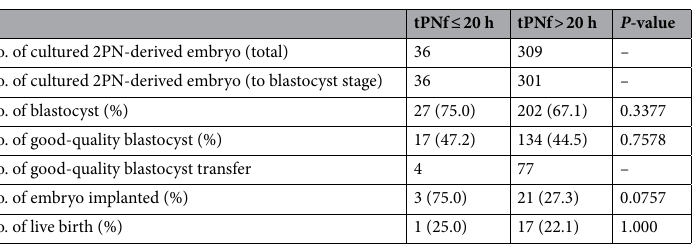
Table 4. Clinical outcome of earlier PN fading embryos in TLM group. Data are shown as numbers (percentages). PN pronuclei; TLM time-lapse monitoring; tPNf time of PN fading.